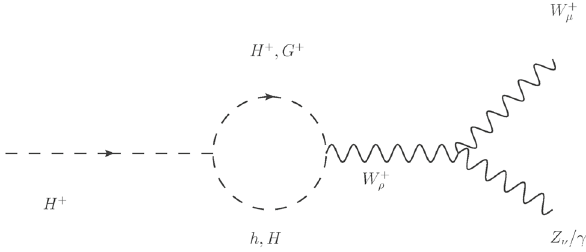
Fig. 5 Set B (cid:5) of one-loop amplitudes for 2HDM